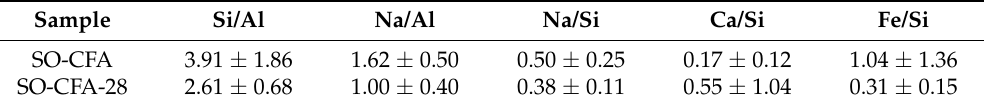
Table 5. Summary of molar ratios based on the result of EDX analysis of gel formation.